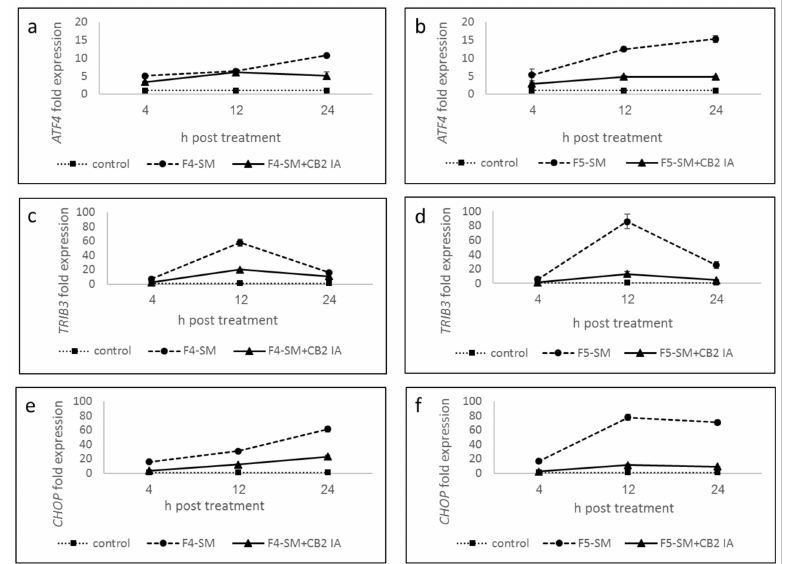
Figure 5. Quantitative PCR determination of the RNA steady-state level in A172 cell line of ATF4 ( a , b ), TRIB3 ( c , d ), and CHOP ( DDIT3-3 ) ( e , f ) genes, after treatment with F4-SM or F5-SM (10 µ g/mL) relative to control. Control is vehicle control (1.2% v / v methanol). Gene transcript values were determined by quantitative PCR. Mean values ± SE are shown ( n = 3). Statistical analysis of gene expression results are in Supplementary Table